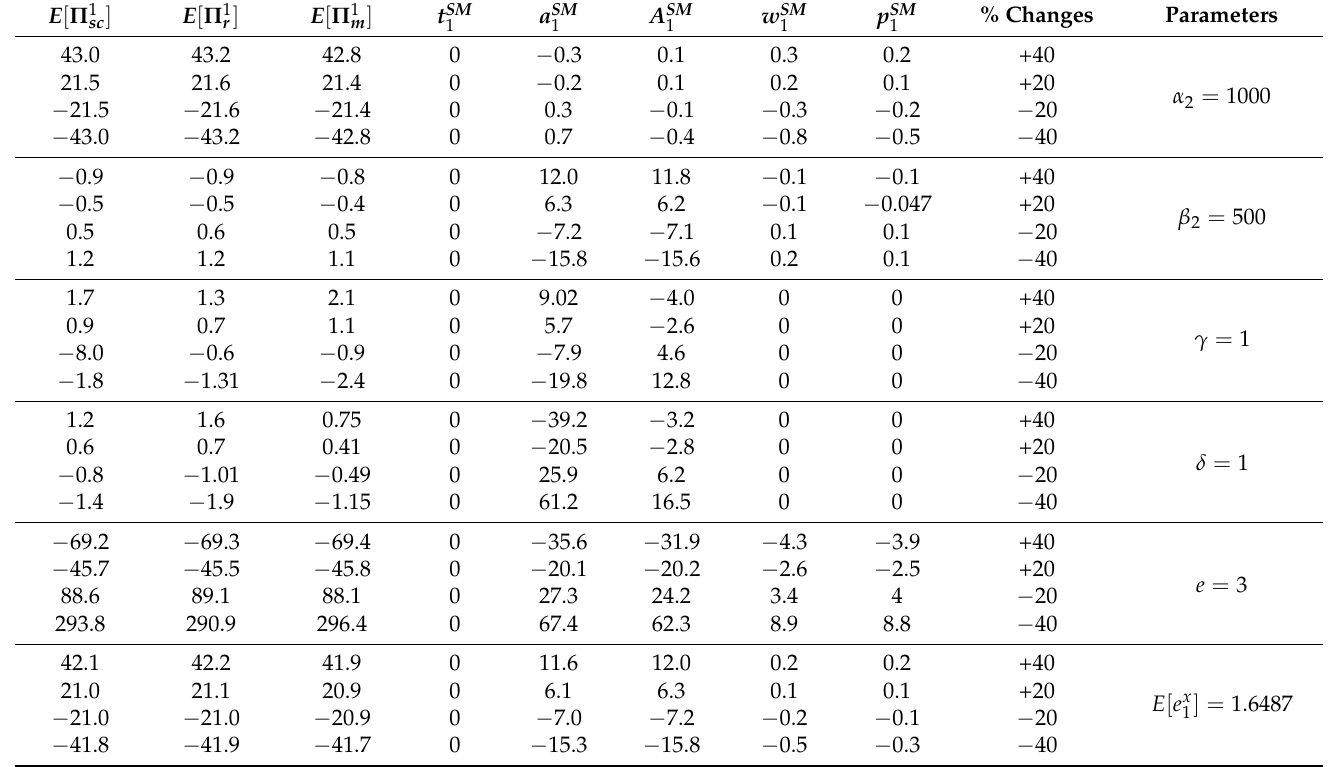
Table 8. The results of the sensitivity analysis in the SG-ML for the first model.